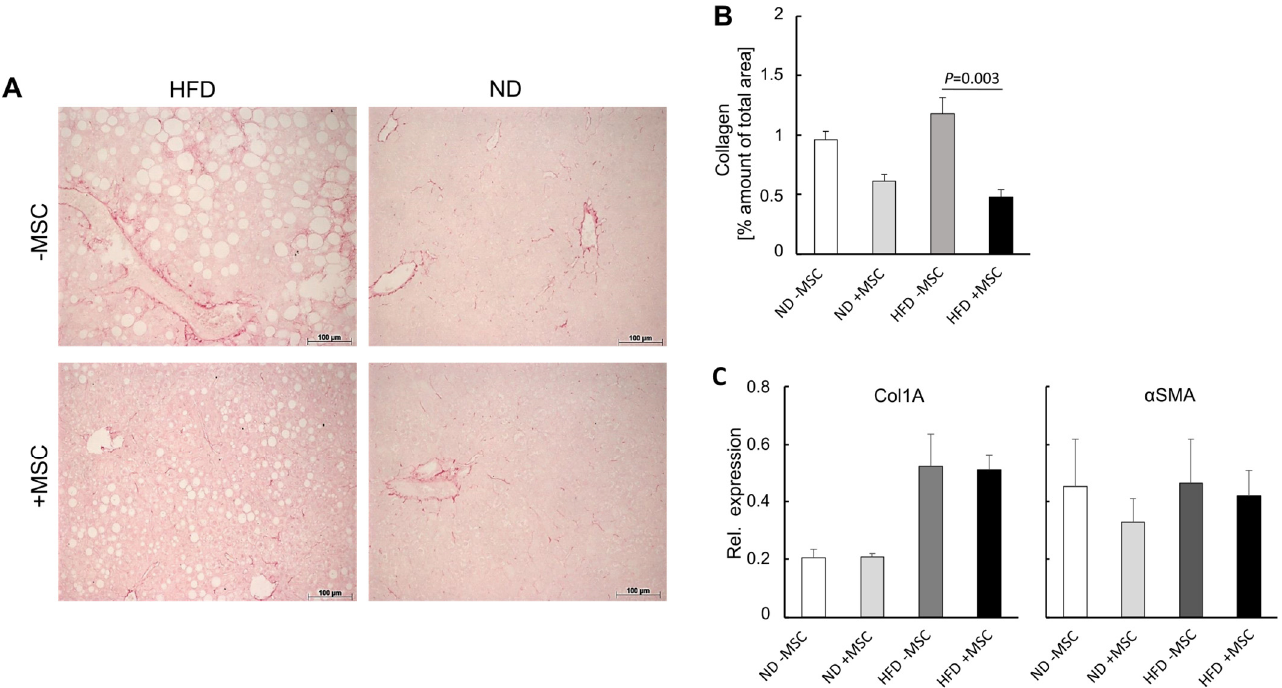
Figure 5. MSC treatment ameliorates fibrosis in livers of high-fat-diet-fed mice: ( A ) collagen was detected histochemically by staining with Sirius red in liver slices from animals either fed the high fat diet (HFD) or not (ND); where indicated, mice were treated with human MSC (+MSC) or left untreated ( − MSC); pictures are representative for 3 different animals out of each group (orig. magnification: 20×; Scale bar—100 µm); ( B ) quantitative image analysis of pictures shown representatively in ( A ); values are means ± SD from 3 (ND − MSC), 4 (ND + MSC), 6 (HFD − MSC) and 8 (HFD + MSC) animals per group; from each animal, 10 tissue slices were analyzed using ImageJ as described; statistics were calculated with SPSS 23; after evaluation of standard distribution, the Kruskal-Wallis algorithm and post hoc Bonferroni were applied for calculation of significance; ( C ) abundance of collagen 1A1 (Col1A) and α SMA mRNA as assessed by sqRT-PCR; expression was normalized to the expression of Hprt1 (hypoxanthine phosphoribosyltransferase 1) used as a housekeeping gene; values are means ± SEM from 3 (ND − MSC), 4 (ND + MSC), 5 (HFD − MSC) and 6 (HFD + MSC) animals per group.